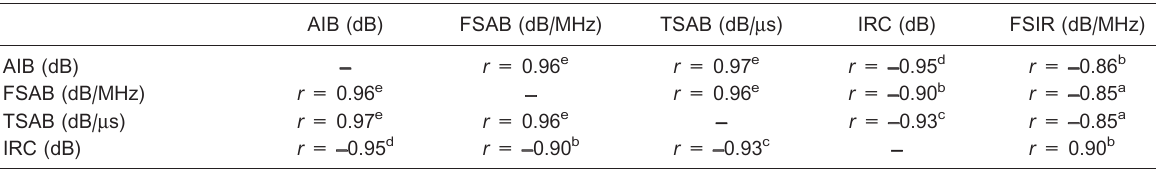
Table 4. Pearson’s correlation coefficient ( r ) of parameters and P for Experiment